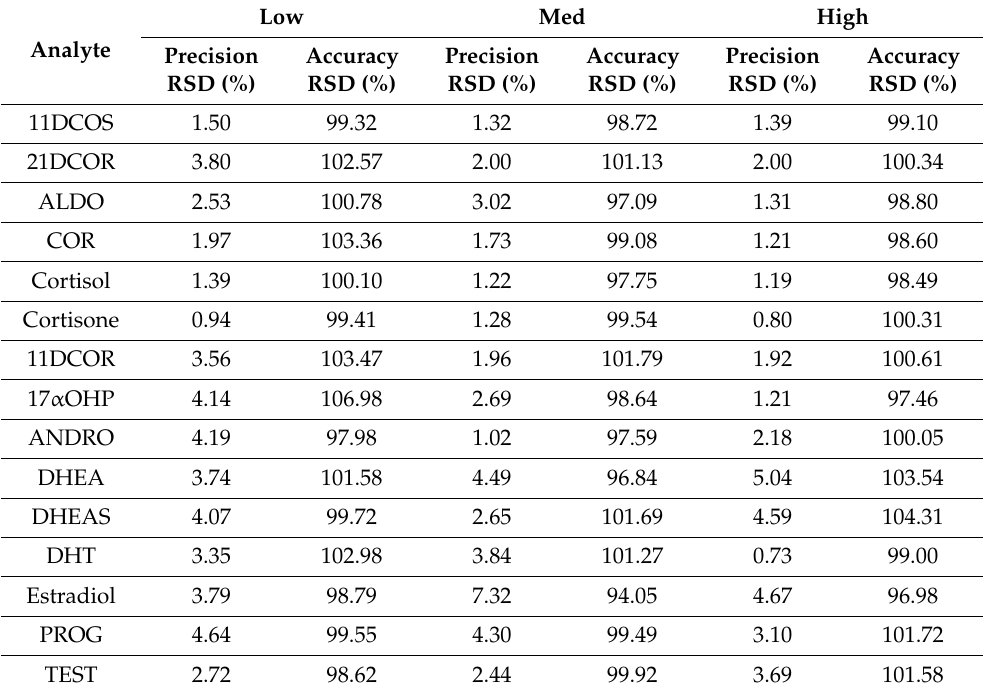
Table 4. Inter-day stability of QC at three levels (low, medium, and high) for 5 consecutive days indicated as percentage of precision and accuracy RSD.